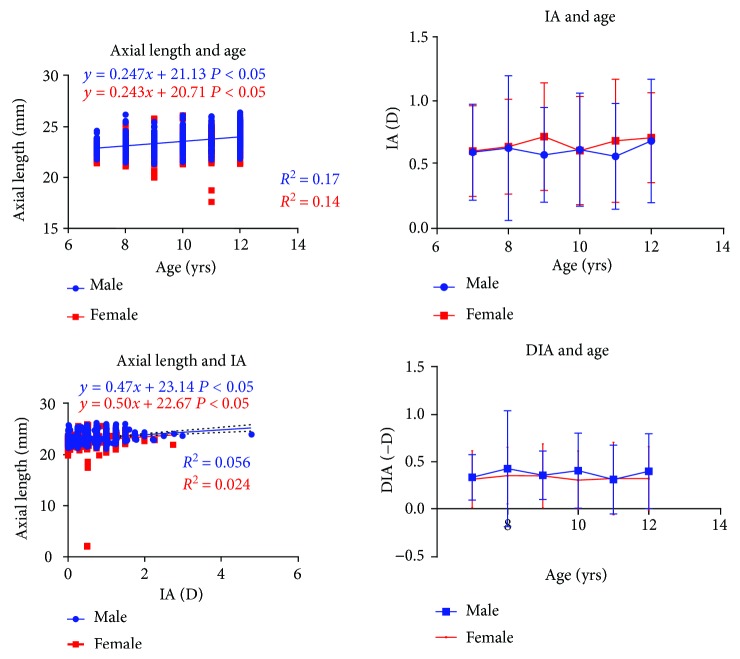
The relationship between axial length and age as well as the relationship between internal astigmatism age.